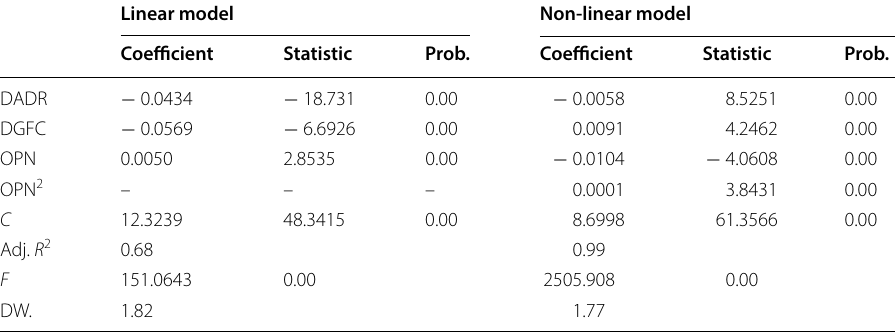
Table 4 Resulted coefficients and statistics of Model 1-L and Model 1-N